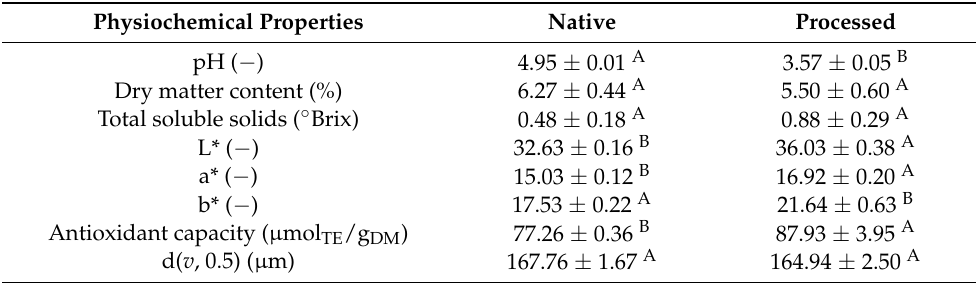
Table 1. Physicochemical properties of native and processed Robusta coffee pulp puree.